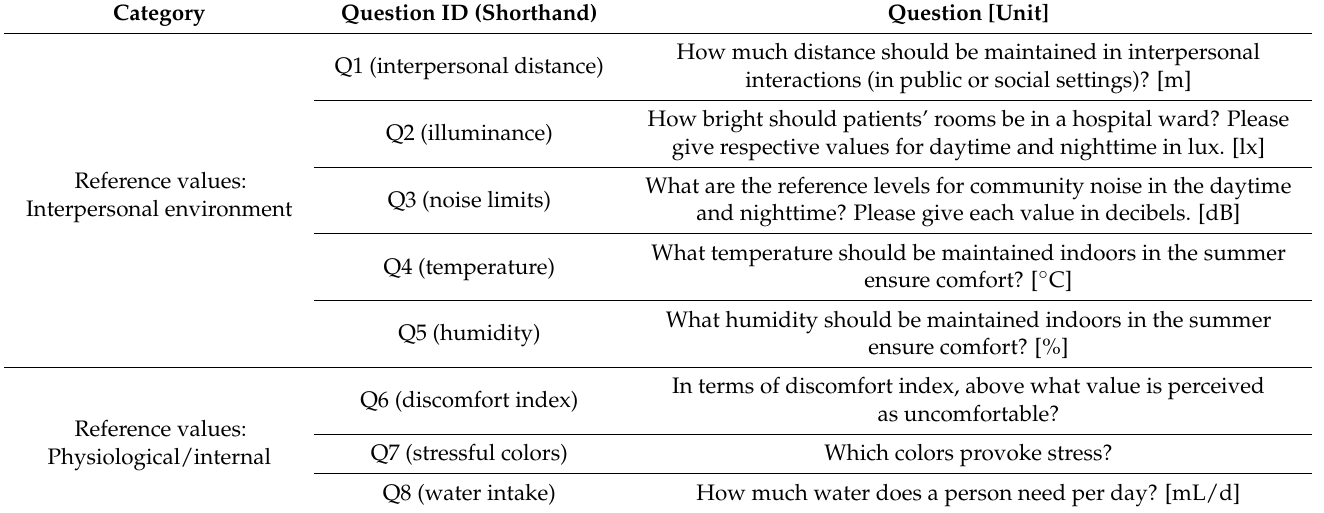
Table 1. Knowledge